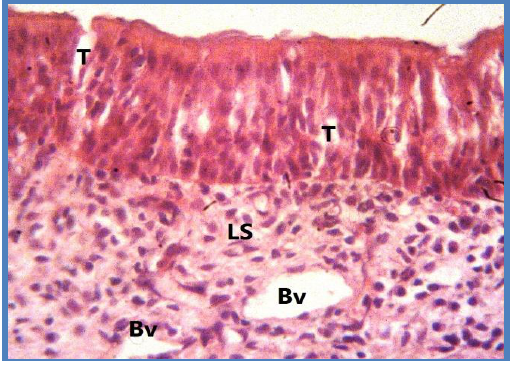
Histological section of nasal cavity (vestibule) showing: A-stratified squamous epithelia,LS- lamina propriasubmucosa,Sg-srous glands, Bv-blood vessel ( H&EX40).